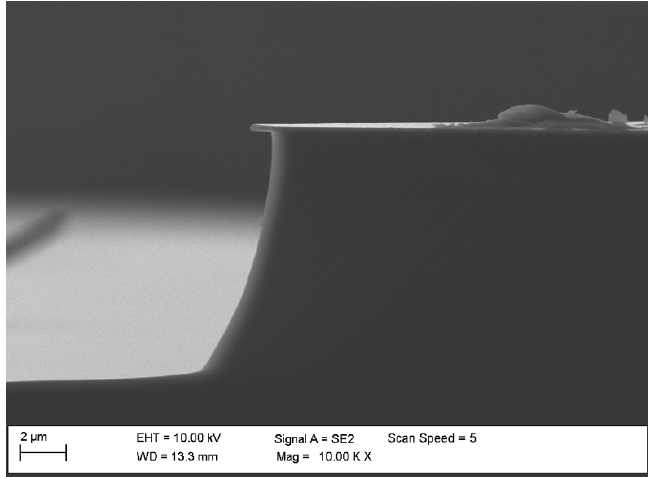
Figure 6. The edge SEM image of the SiC/Cr MESA structure with clearly pronounced Cr mask undercut after the etching process with the following parameters: SF 6 flow rate = 100 sccm, P RIE = 25 W, P ICP = 2500 W, p = 7 mTorr, t = 119 min.